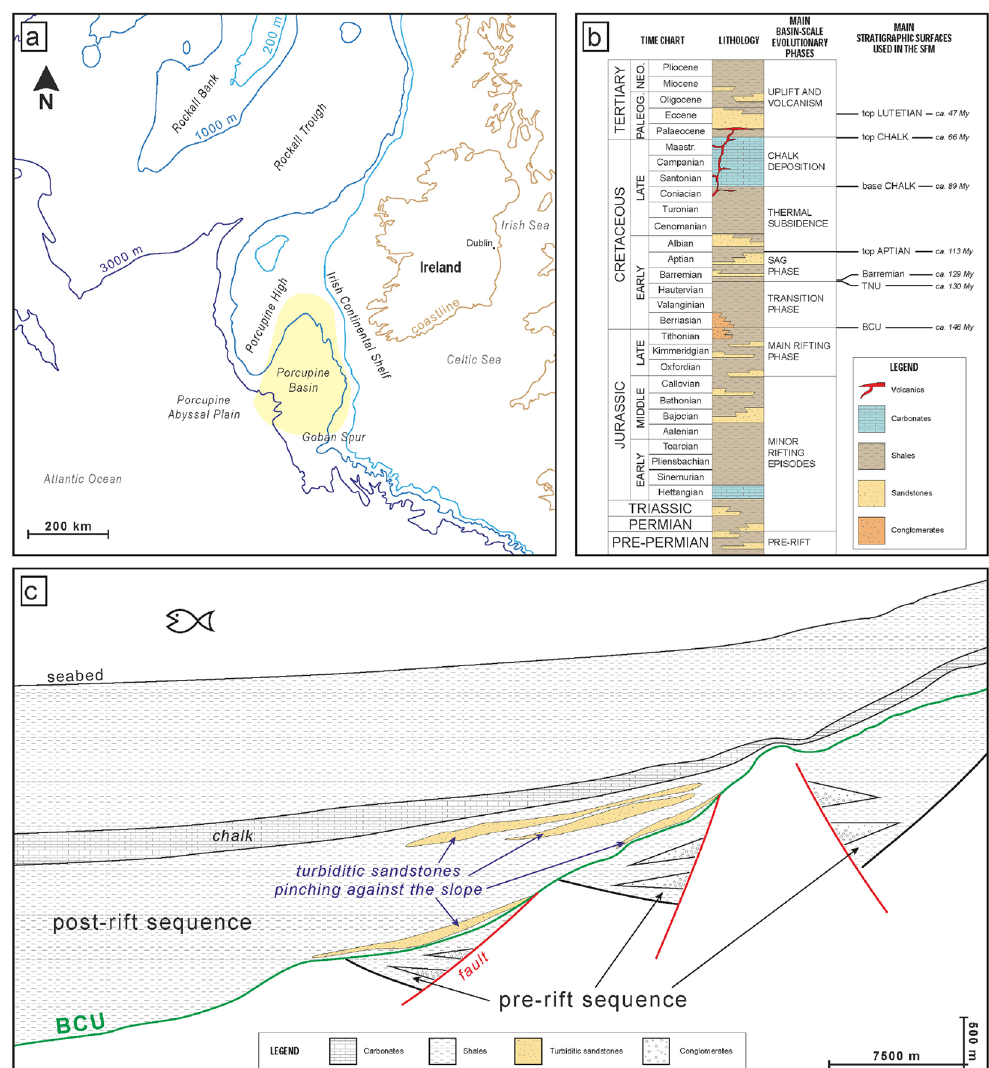
Figure 1. ( a ) Location of the Porcupine Basin (yellow) in the context of the Irish Atlantic margin. ( b ) Generalized stratigraphy of the Porcupine Basin (modified from Shannon, 1992 30 ), with indication of the main section across the eastern margin of the Porcupine Basin, derived from original seismic interpretations. The inferred position of updip-pinching base-of-slope turbiditic sandstones is shown. This kind of sandstones are the key object of the present